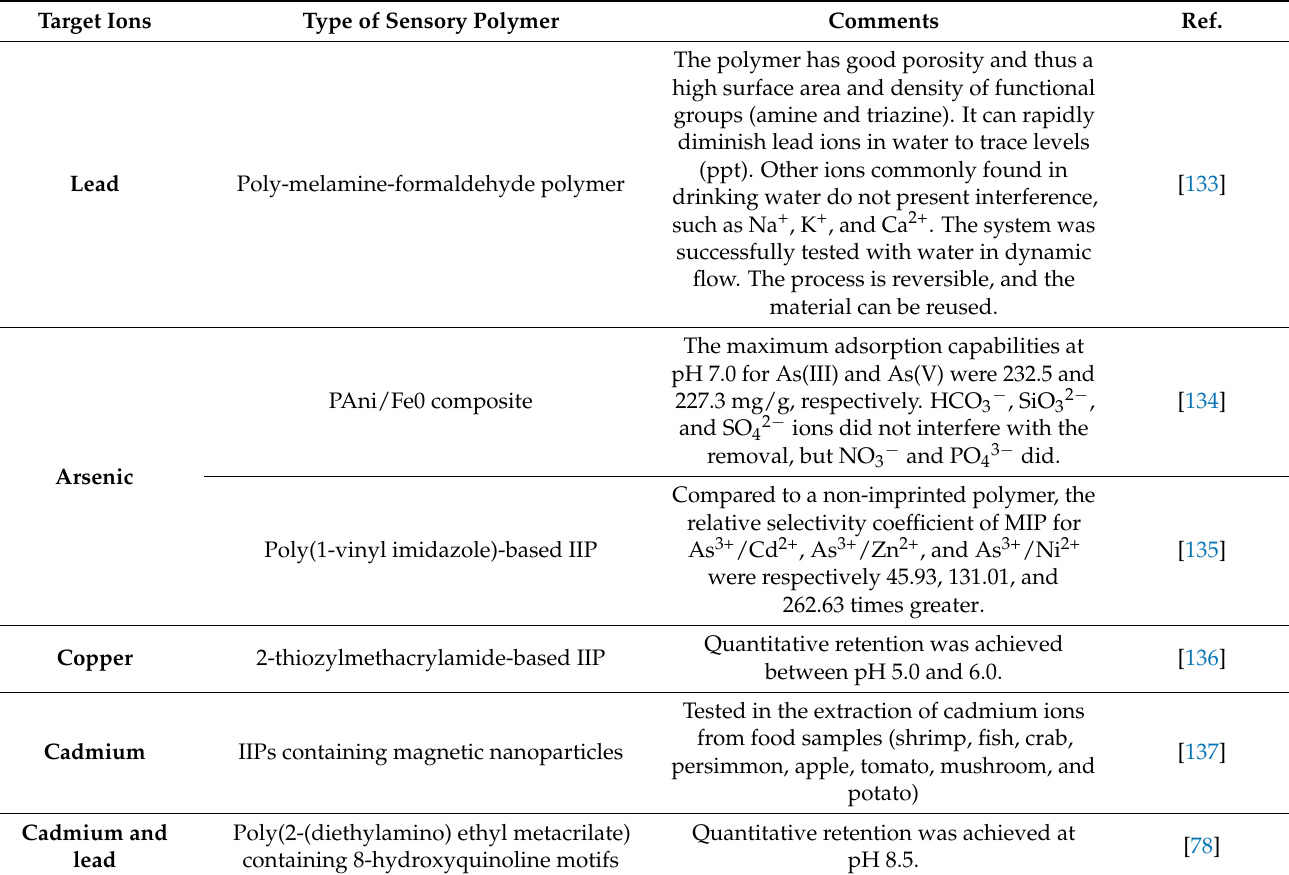
Table 3. Classification of the most relevant works of the last ten years about heavy metal removal from drinking water, identifying the target heavy metal, and the type of polymer.